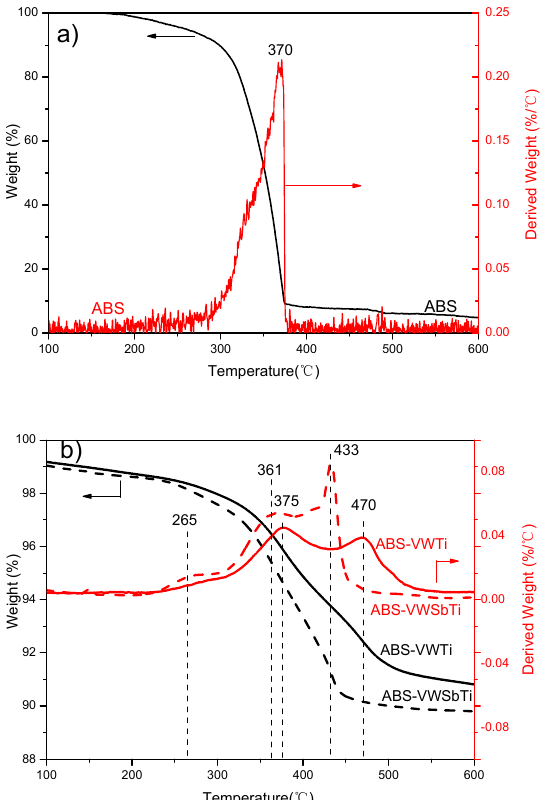
Figure 7. Thermogravimetric curves of different samples. ( a ) TG and DTG curves of pure ammonium bisulfate (ABS); ( b ) TG and DTG curves of ABS-VWTi and ABS-VWSbTi.